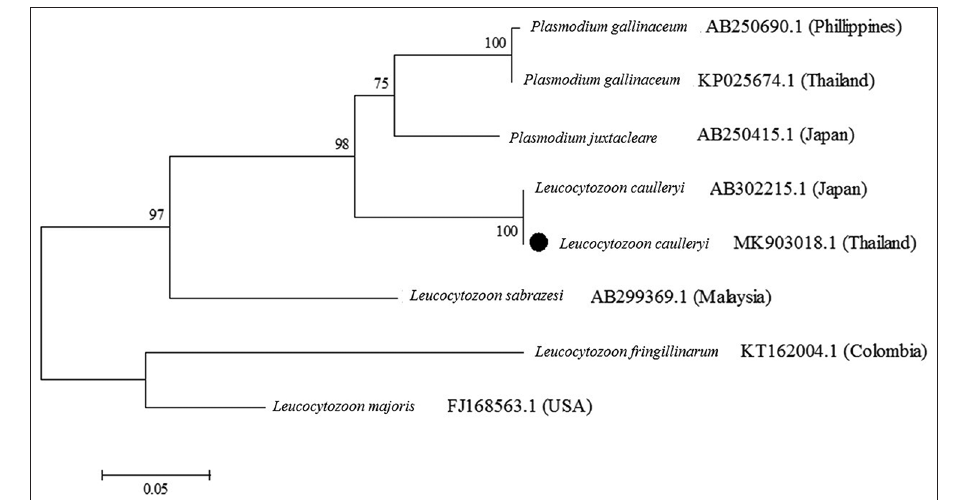
Figure-4: Neighbor-joining phylogenetic tree based on the partial cox I gene (588-bp) of Leucocytozoon caulleryi in backyard chickens in Khon Kaen Province (black circle). Plasmodium juxtanucleare and Plasmodium gallinaceum as an out group and Leucocytozoon spp. from other species was taken from GenBank. Four strains are indicated that the Leucocytozoon species name, the accession number and the country where the pathogen was reported. Bootstrap values are listed as percentages after 1000